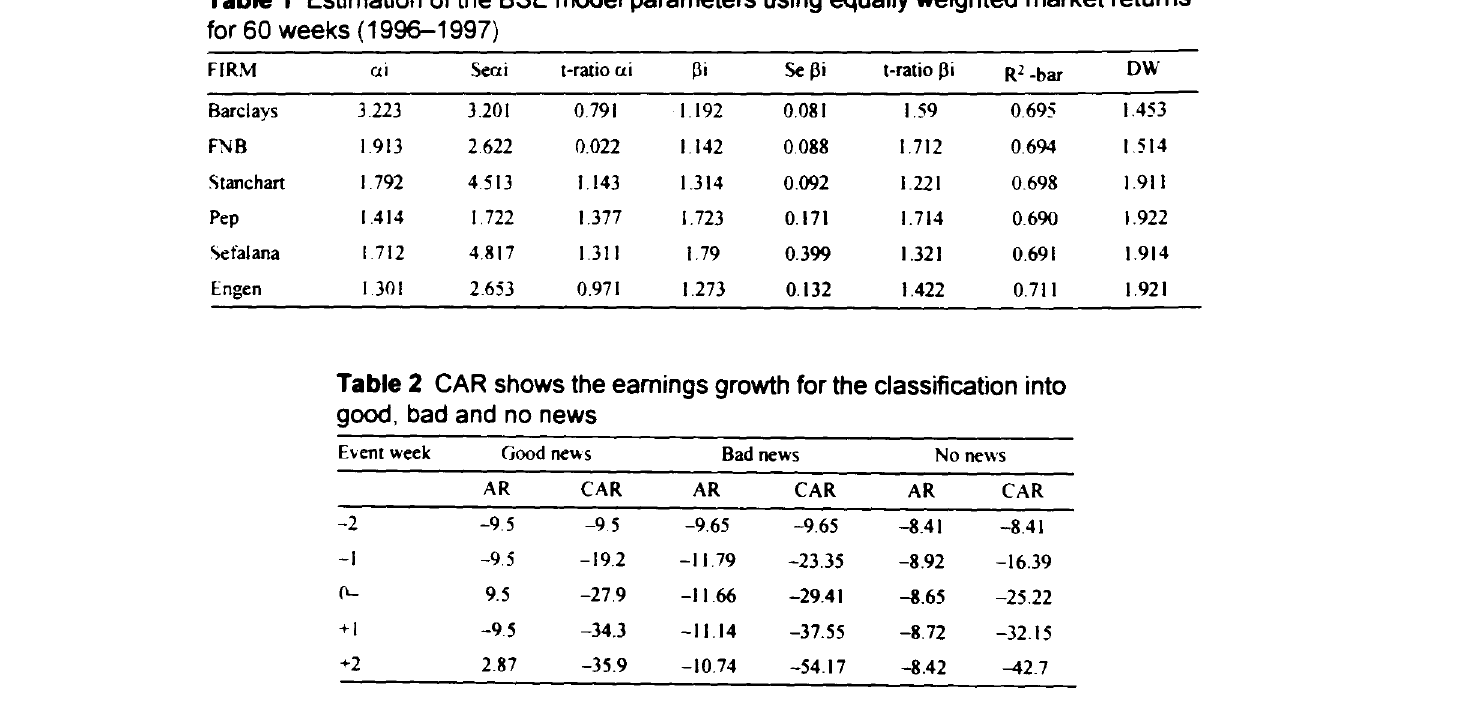
Table 1 Estimation of the BSE model parameters using equally weighted market